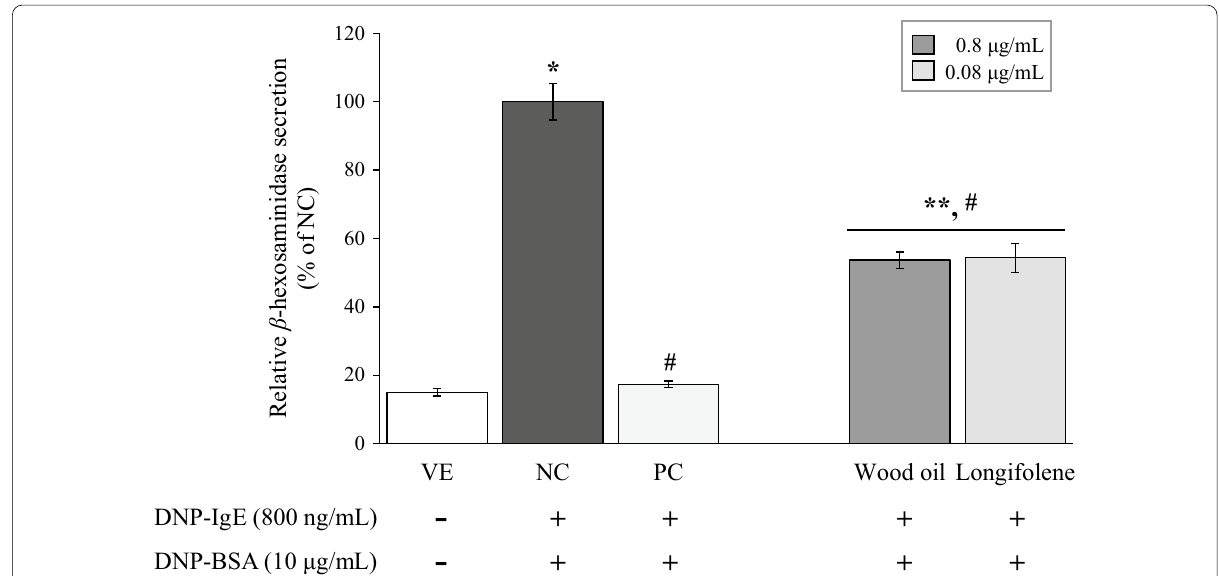
Fig. 8 Inhibitory effect of longifolene on β ‑hexosaminidase release. VE: vehicle, DMSO; NC: negative control, 800 ng/mL DNP‑IgE and 10 μg/mL DNP‑BSA treated group; PC: positive control, 100 nM dexamethasone treated group, an oil (0.8 μg/mL) and longifolene (0.08 μg/mL). Values are presented as mean standard deviation. * p < 0.05 and ** p < 0.01 compared with VE; and # p < 0.05 compared with ±